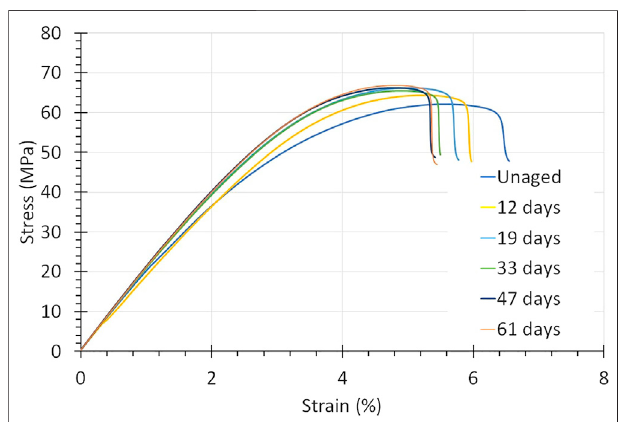
FIGURE 11 | Stress-strain curves of PSU exposed to 45 wt% KOH at 90 ° C. In particular, the strain to rupture shrinks, but this levels off with aging time.